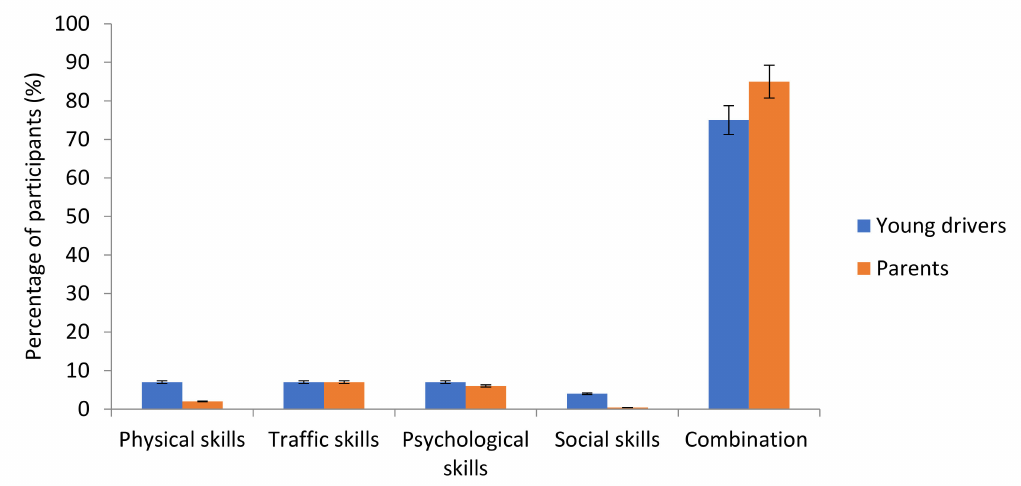
Figure 2. Percentage of young driver and parent responses indicating the type of skill that should be trained using a driving simulator.